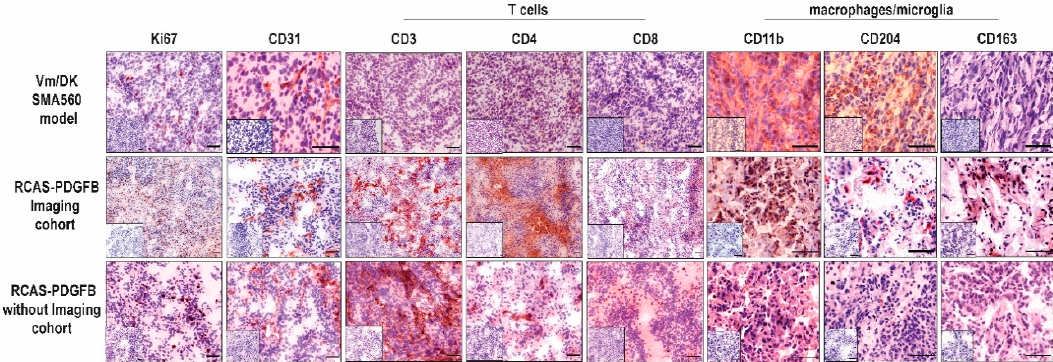
Figure 4. Immunohistochemical comparison of established T cell, microglia/macrophages, and vascularisation markers as indicated above. Representative IHC staining patterns of tumor tissues of either VM/Dk mice treated with an isotype control antibody (MOPC-21), as described in Przystal et al., or transgenic mice after the implantation of RCAS-PDGFB transfected DF1 cells. Small inserts show staining control without the application of primary antibody. Scale bars are 100 µm.